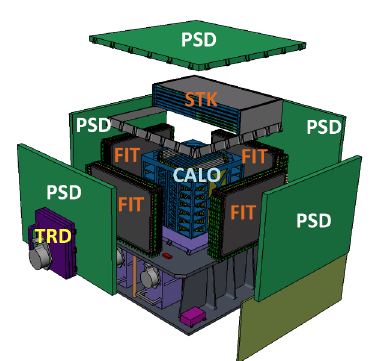
Figure 2. Exploded view of the HERD detector. The whole apparatus will have a weight < 4 t and a volume of (2 . 3 × 2 . 3 × 2 . 6) m 3